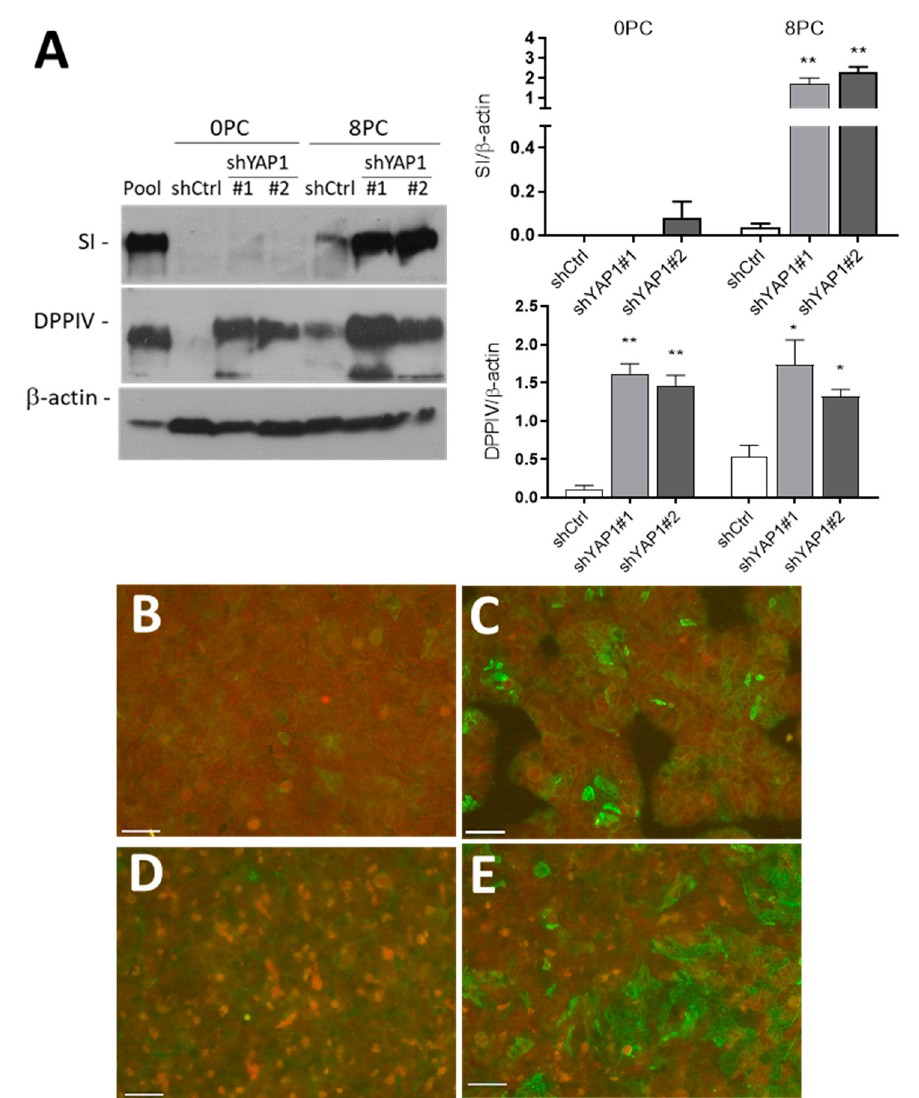
Figure 7. YAP1 knockdown stimulates absorptive cell differentiation. ( A ) Representative Western blot analysis and data compilation from three separate experiments showing higher expression of SI and DPPIV in shYAP1#1 and shYAP1#2 expressing cells relative to shCtrl cells at both Day 0 (0PC) and Day 8 (8PC) post-confluence. β -actin was used as a loading control. * p < 0.05, ** p < 0.005. ( B–E ) Indirect immunofluorescence analysis for the detection of DPPIV positive cells in shCtrl (B,D) and shYAP1#2 (C,E) at 0PC (B,C) and 8 PC (C,E). Bar = 50 μ m.